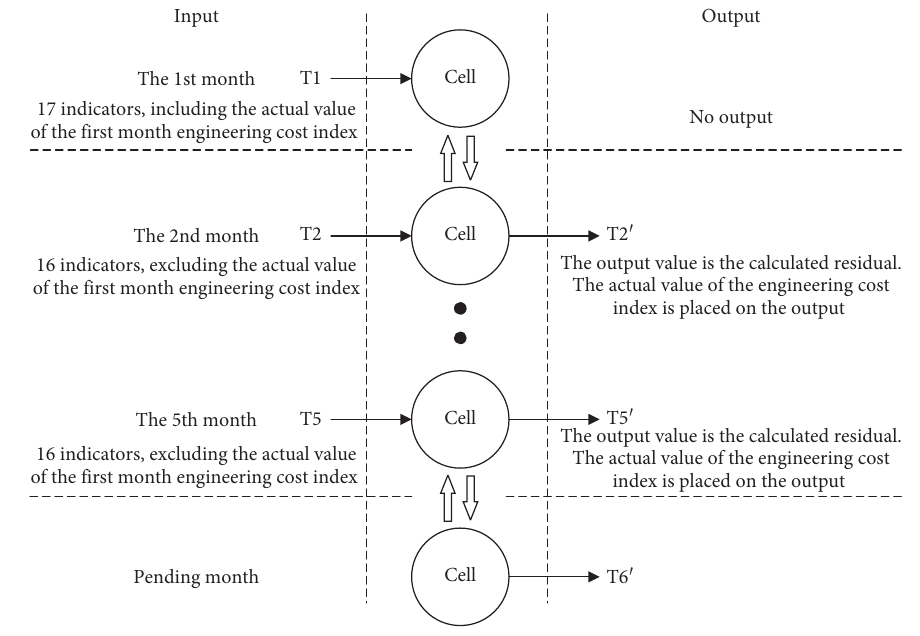
Figure 1: LSTM model data input